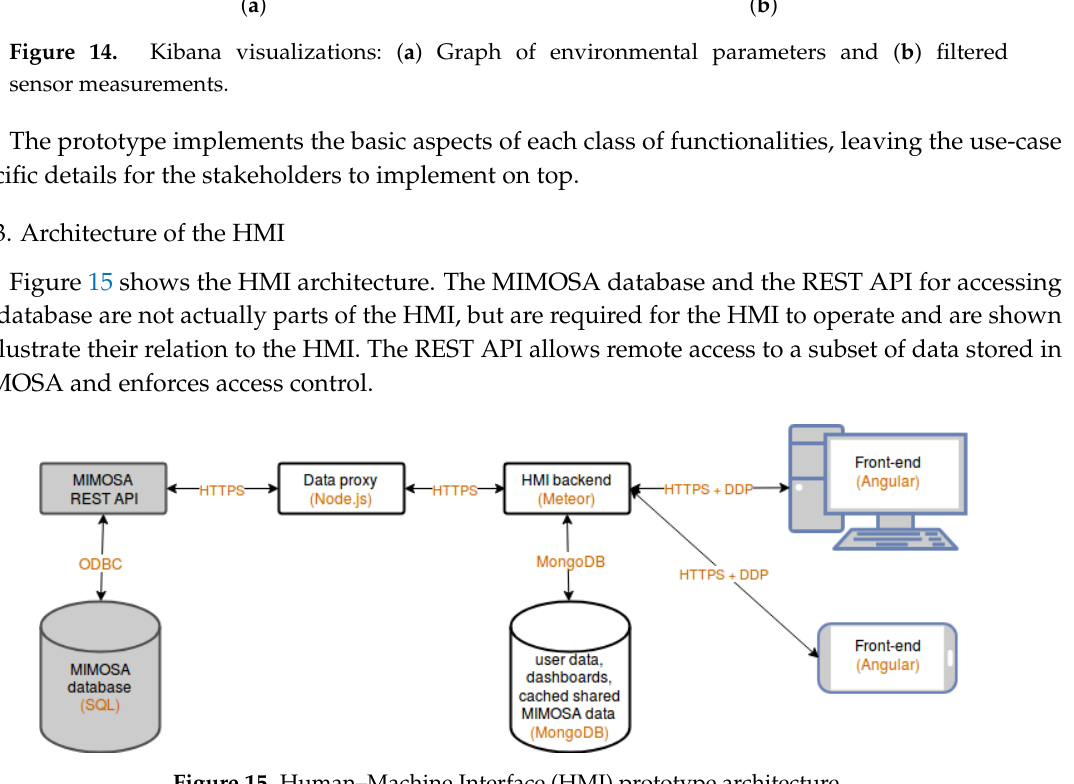
Figure 15. Human–Machine Interface (HMI) prototype